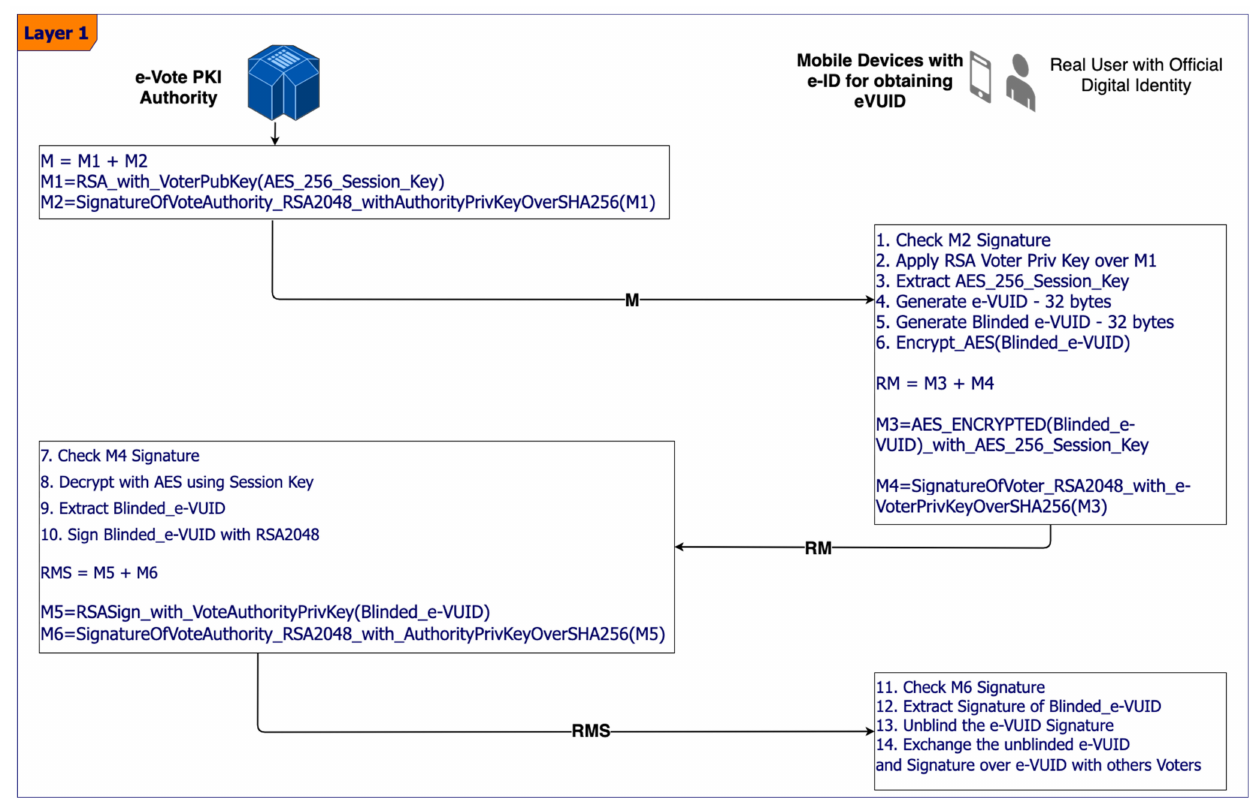
Figure 4. Protocol between e-Vote Authority and the voters, including the blinding